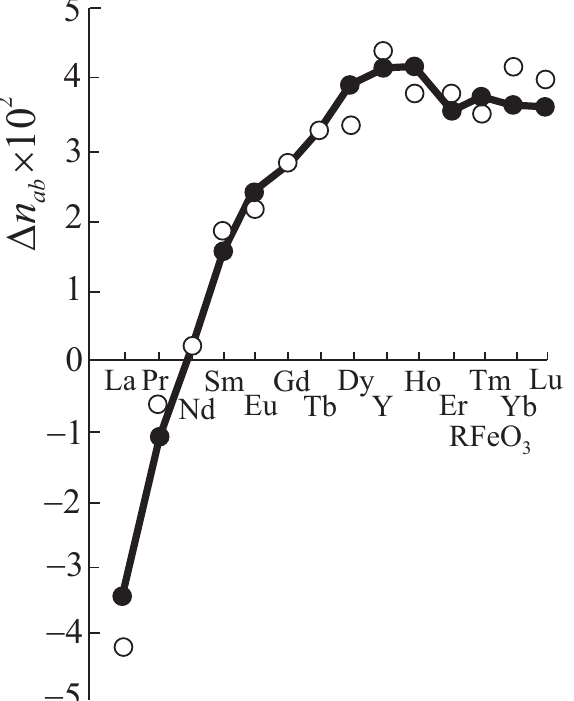
Figure 8. Linear birefringeance ∆ n ab for orthoferrites RFeO 3 in ab plane: solid circles are predictions of the deformation model, hollow circles are experimental